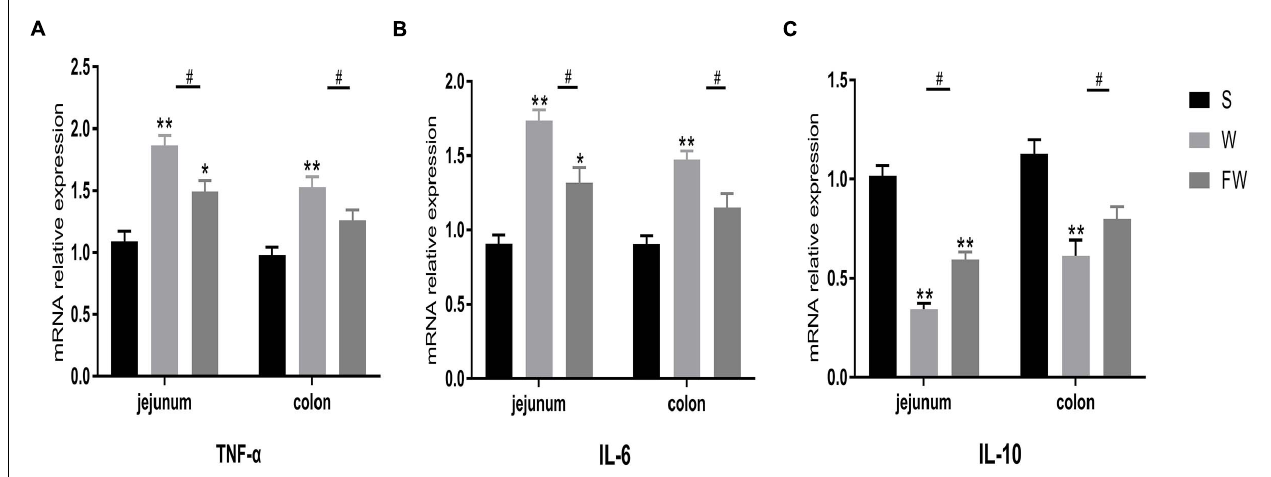
FIGURE 8 | Intestinal mucosal cytokines level of three groups. The relative mRNA expression of proinflammatory cytokines IL-6 (A) , TNF- α (B) , and anti-inflammatory IL-10 (C) were determined by qRT-PCR. The symbol “*” represented that the W and FW groups were compared with the S group, the symbol “#” represented that the FW group was compared with the W group. Data were shown as mean ± SEM for the three different experiments (* p < 0.05, ** p < 0.01, *** p < 0.001, and # p < 0.05) (S, Sucking; W, Weaned; FW: